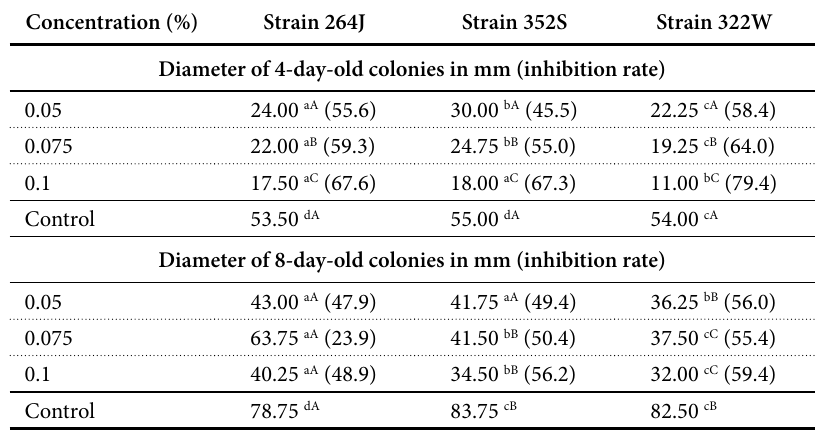
Tab. 6 Influence of Biosept Active on the growth of Diaporthe eres strains.